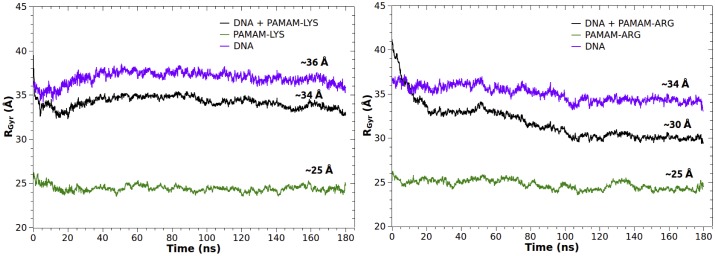
Time evolution of the radius of gyration (Rgyr) of DNA, dendrimer and the dendrimer-DNA complex for a) PAMAM-Lys and b) PAMAM-Arg.